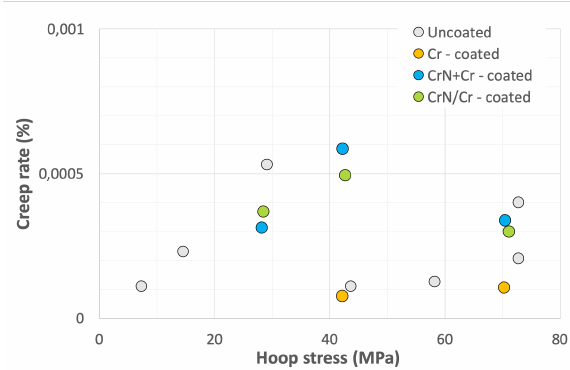
Figure 9. Opening size at temperature 800 ◦ C in relation to hoop stress for different types of coatings and uncoated specimens